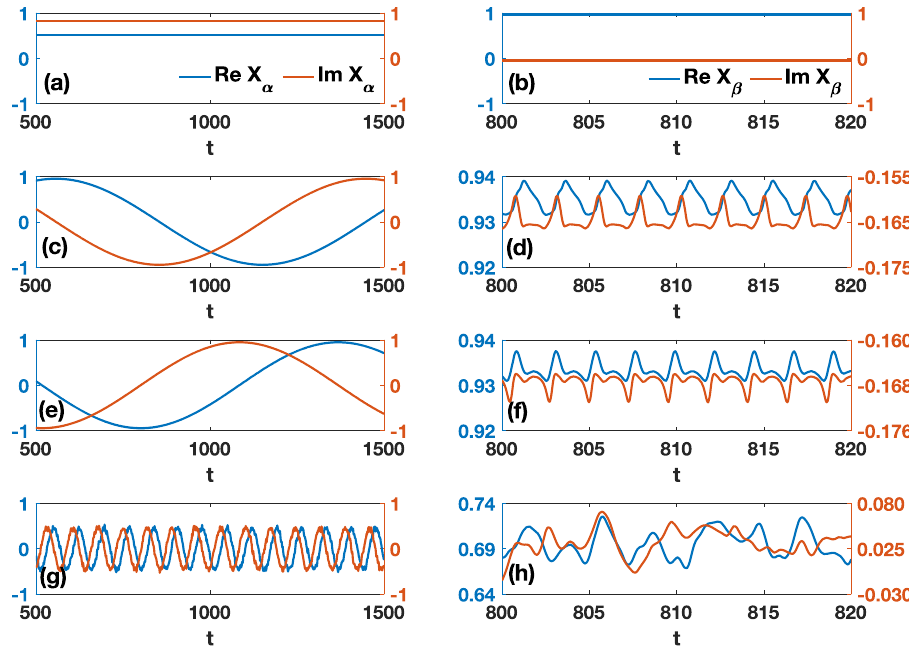
Fig. 5 Post-transient time evolution of the real and imaginary parts of the parameters X α and X β . Numerical results are shown for a network of size N = 500 during the downward transition. These results are obtained with σ = 4 ( a , b ), σ = 3.4 ( c , d ), for σ = 3.37 ( e , f ) and for σ = 1.69 ( g , h